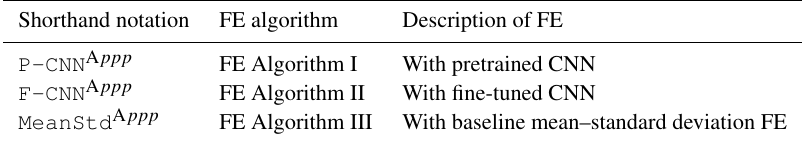
Table 2. Method mnemonics that are used throughout this results section and the corresponding feature extraction (FE) algorithms.